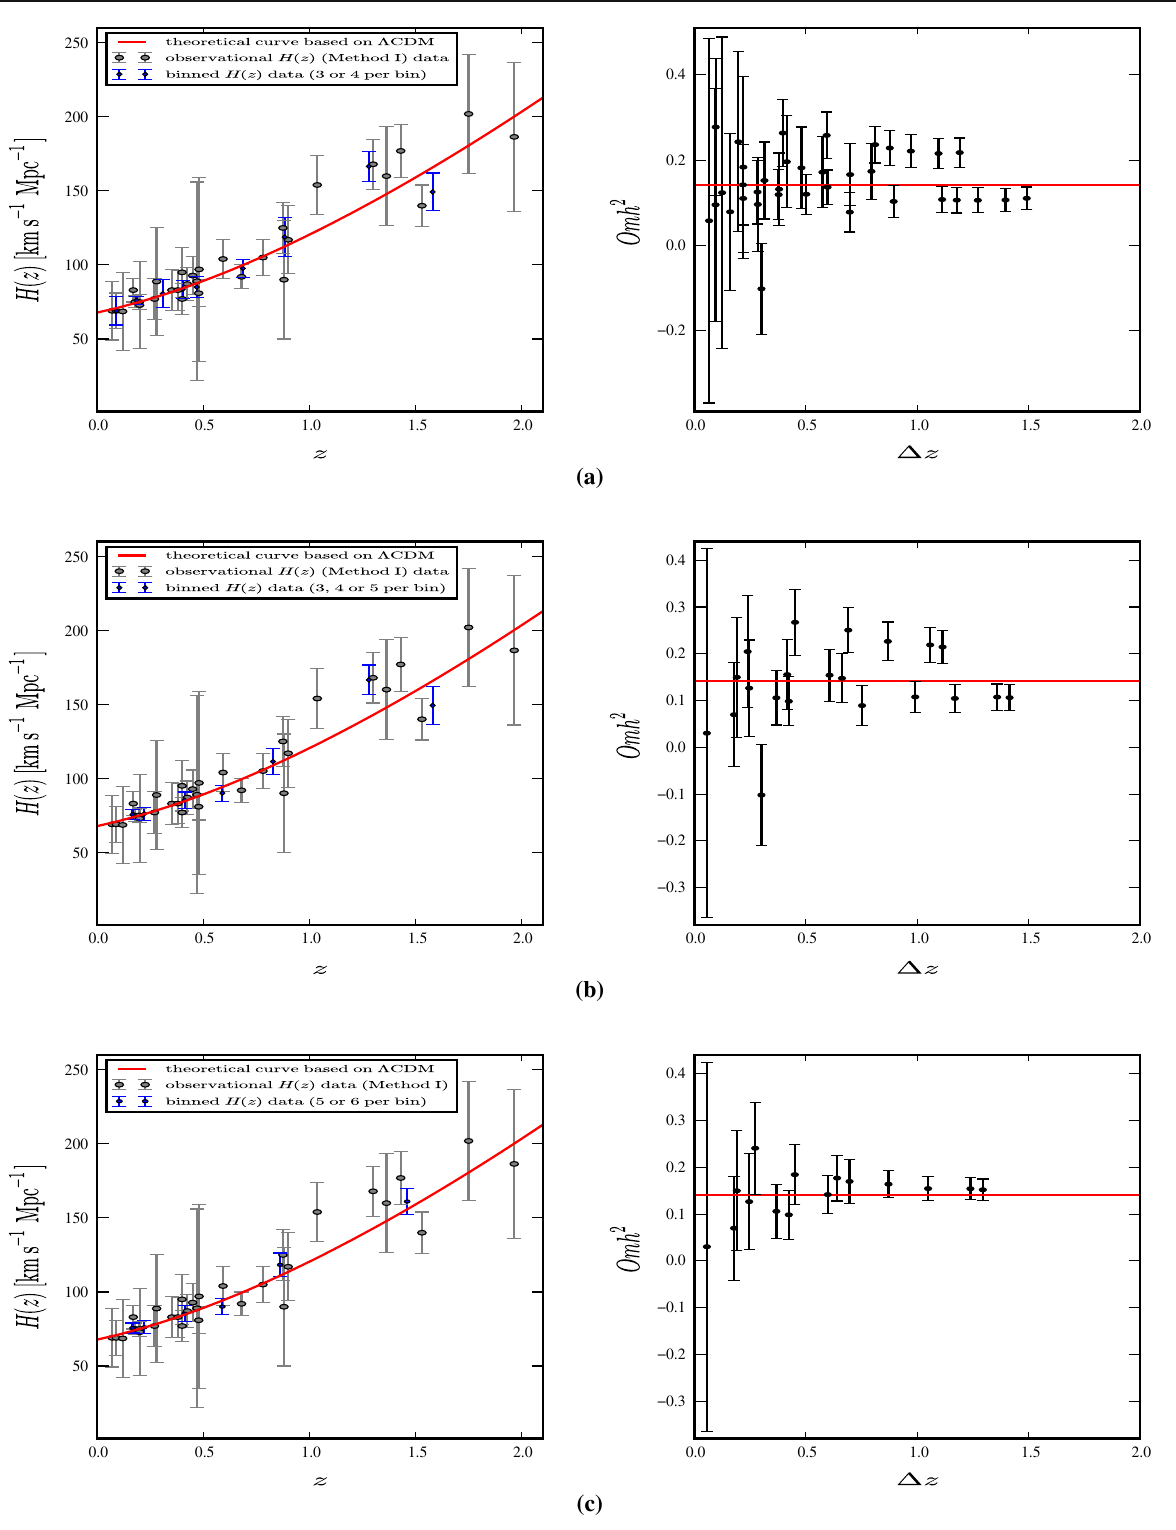
Fig. 5 OHD from the cosmic chronometer method associated with binned data and its corresponding Omh 2 diagnostic values for the weighted mean technique. The panels a – c present the 3–4, 3–4–5 and